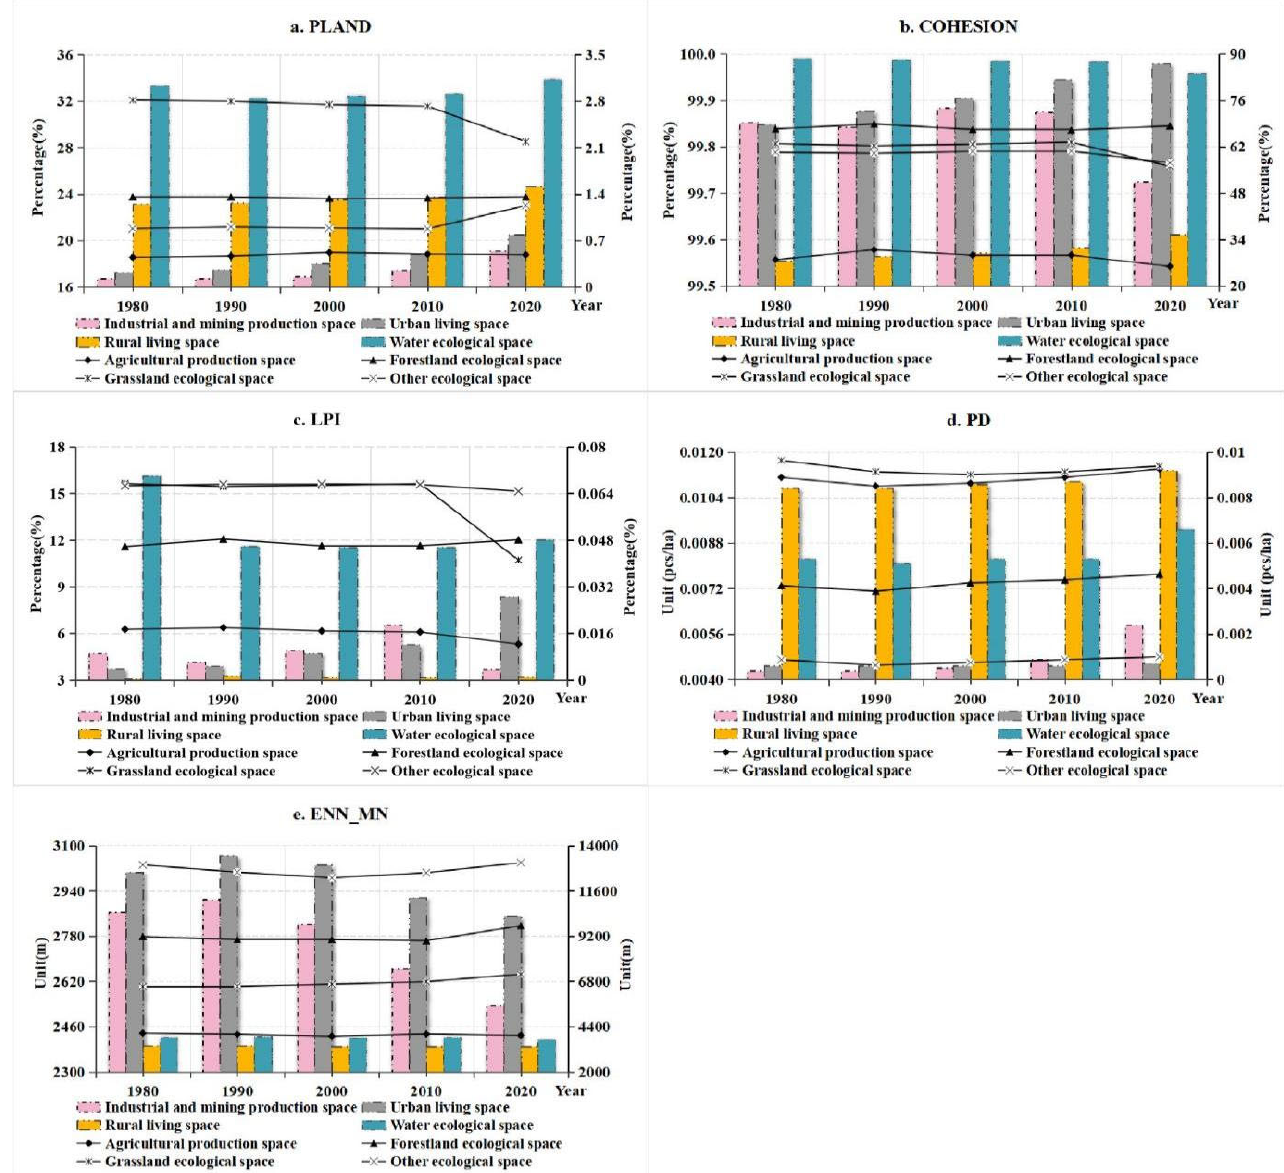
Figure 7. Landscape pattern index of territorial space in China during 1980–2020